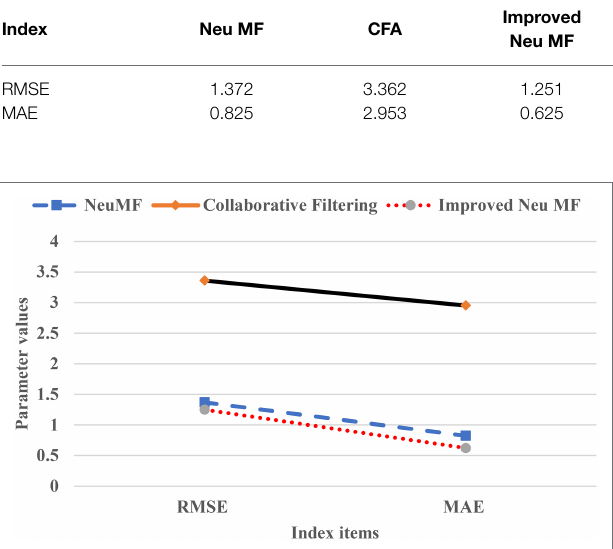
FIGURE 7 | Comparison of root mean square error (RMSE) and mean absolute error (MAE).